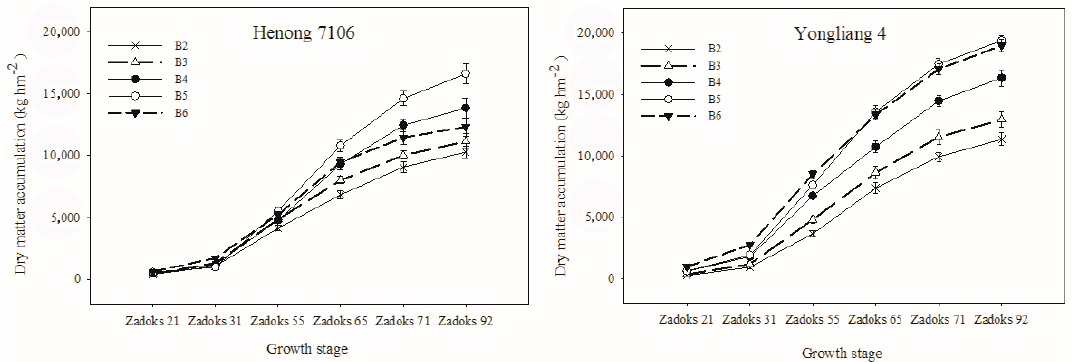
Figure 2. The change in dry matter accumulation (DMA) of wheat sown on different dates (2014– 2015).